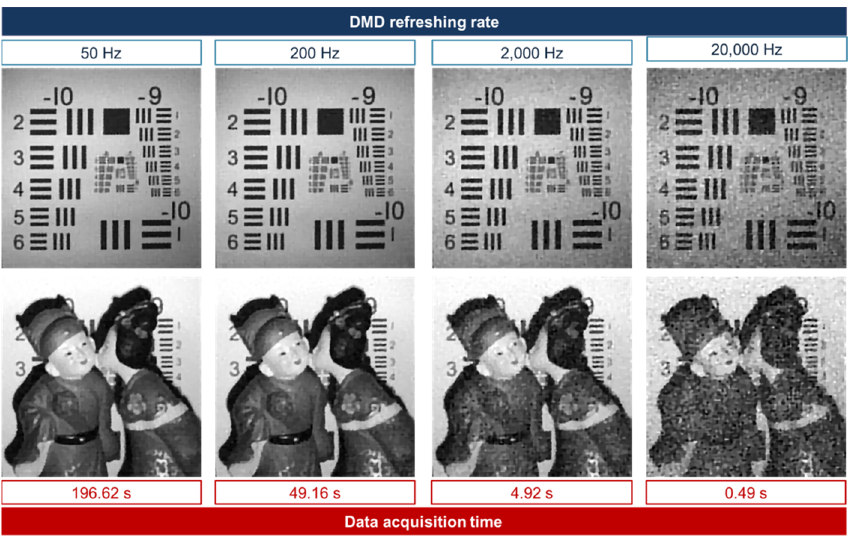
Figure 7. Experiment results reconstructed by the proposed method for different DMD refreshing rates. Sampling ratio = 10%.